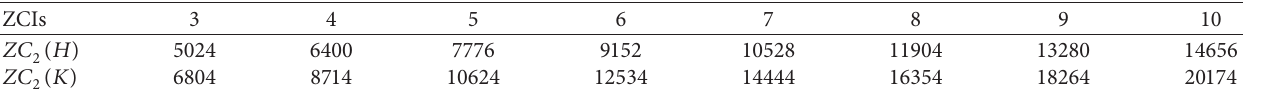
for H and K networks on dimensions 3 ≤ n ≤ 10. 2